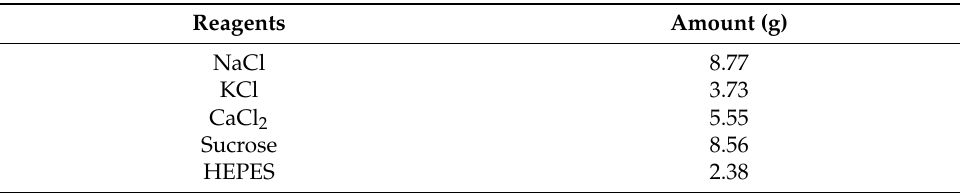
Table 1. Reagents used to make 1 L of HBS.